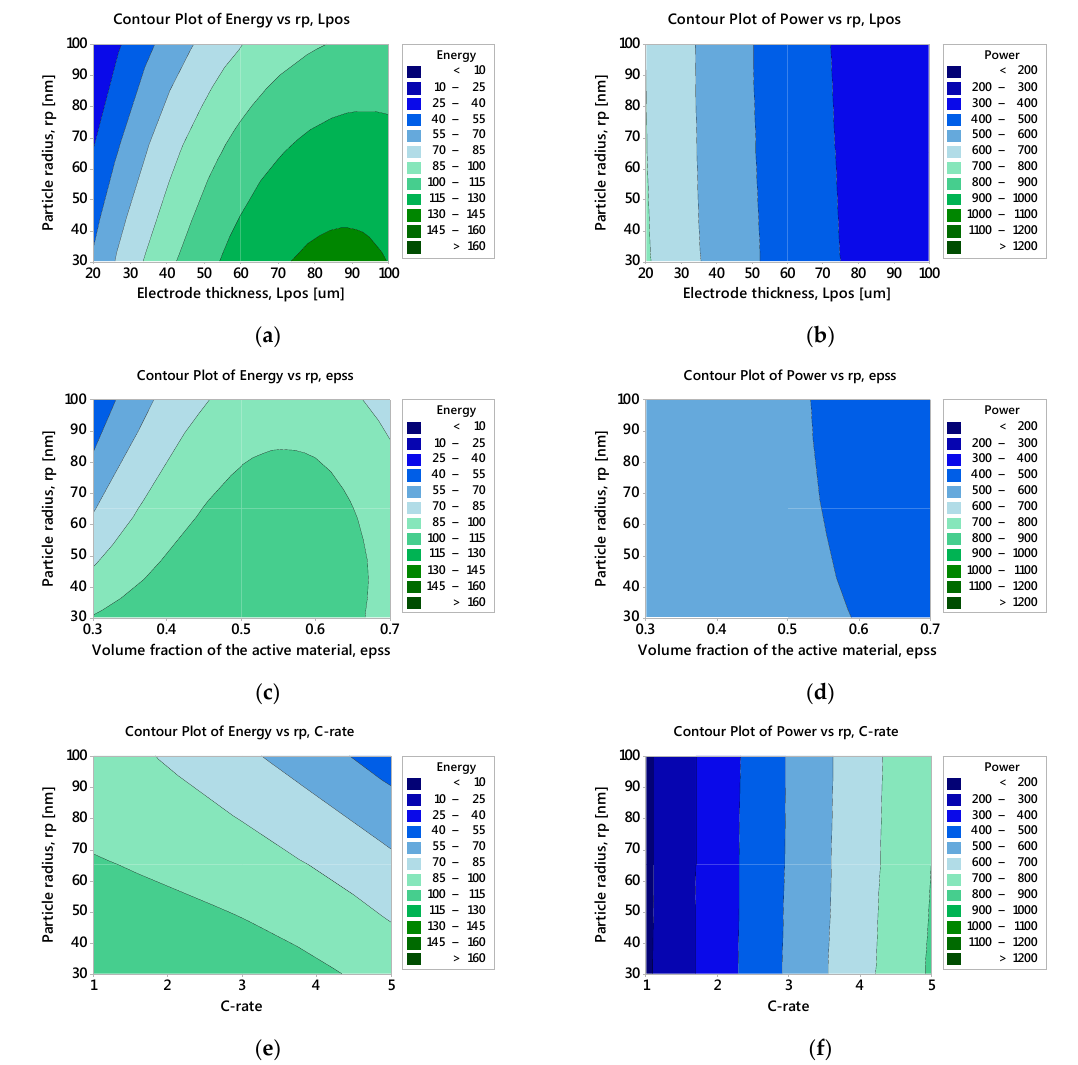
Figure 8. Contour plot of: ( a ) the specific energy as a function of ( r p and L pos ); ( b ) the specific power as a function of ( r p and L pos ); ( c ) the specific energy as a function of ( r p and ε s , pos ); ( d ) the specific power as a function of ( r p and ε s , pos ); ( e ) the specific energy as a function of ( r p and C-rate); ( f ) specific power as a function of ( (cid:1870) (cid:3043) and C -rate).